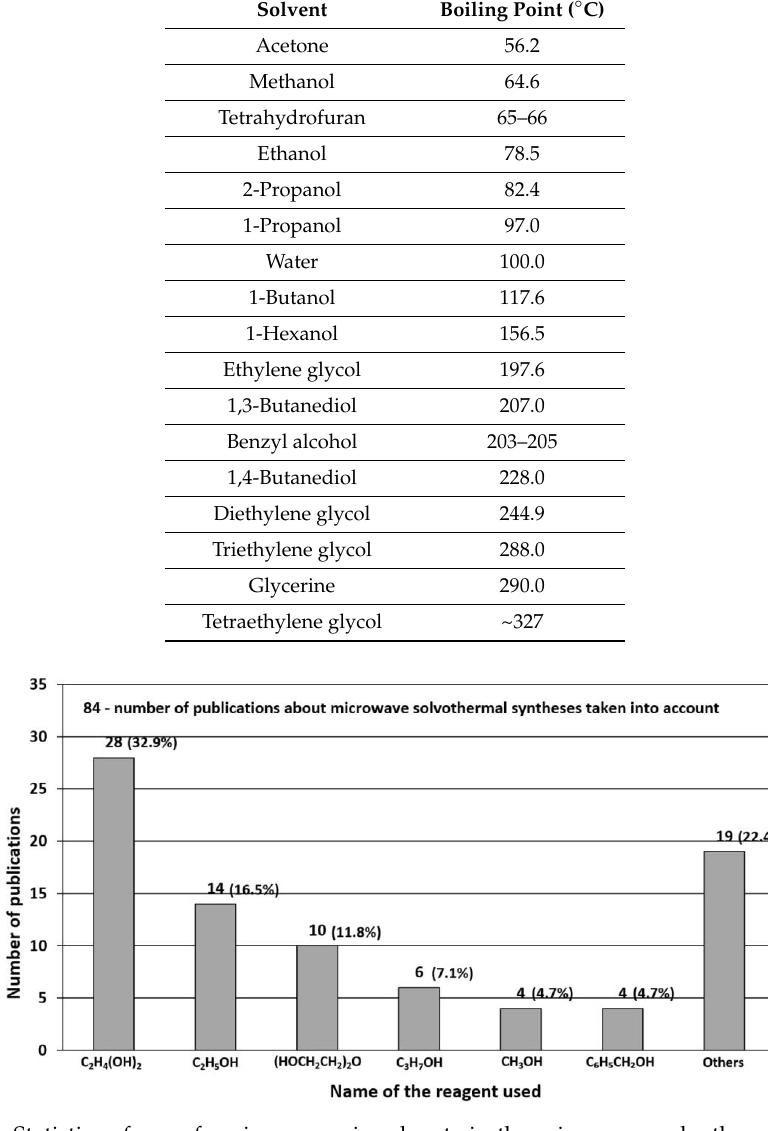
Figure 36. Statistics of use of reactants (Zn 2+ salts) in the microwave solvothermal synthesis. Source: [402,573,758–838]. The most popular reactants being hydroxide anion precursor chemicals “OH - ” used for the ZnO synthesis according to the data collected from the literature review [758–838] (Tables 9–11) (Figure 37) are sodium hydroxide (NaOH), ammonia water (NH 3 ·H 2 O, NH 4 (OH)), as well as amides and amines, e.g., C 2 H 8 N 2 [775], hexamethylene tetramine (C 6 H 12 N 4 ) [786], triethanolamine (TEA, C 6 H 15 NO 3 ) [786], diethanolamine ((CH 2 CH 2 OH) 2 NH) [791], thioacetamide (C 2 H 5 NS) [819]. In over a